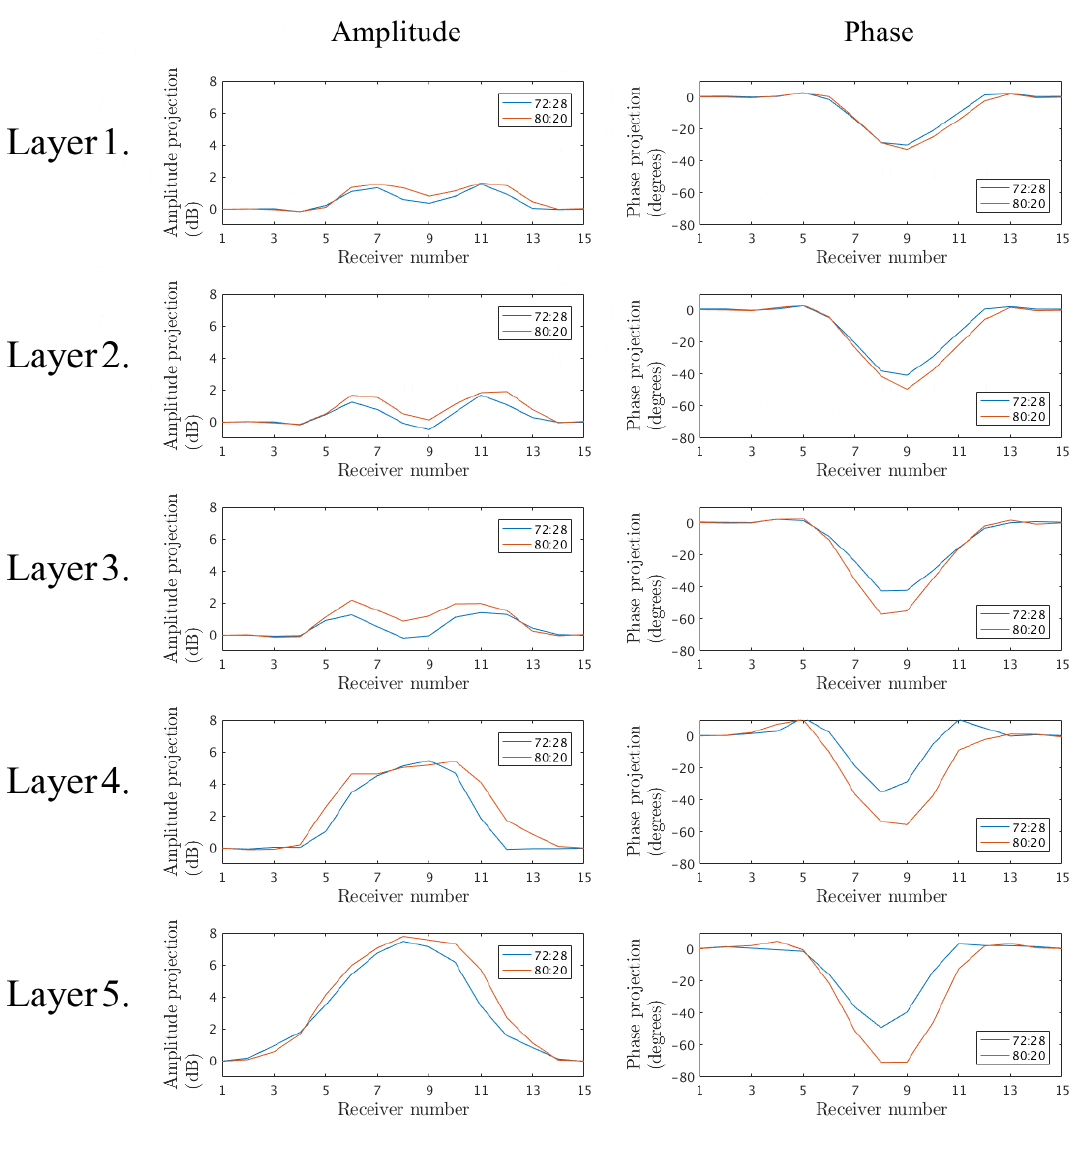
Figure 7. Projection data of the signals transmitted from Antenna 1 at 1500MHz for the five interrogated layers. Measurements of the inner shell filled with the 72:28 and 80:20 glycerin–water mixtures,